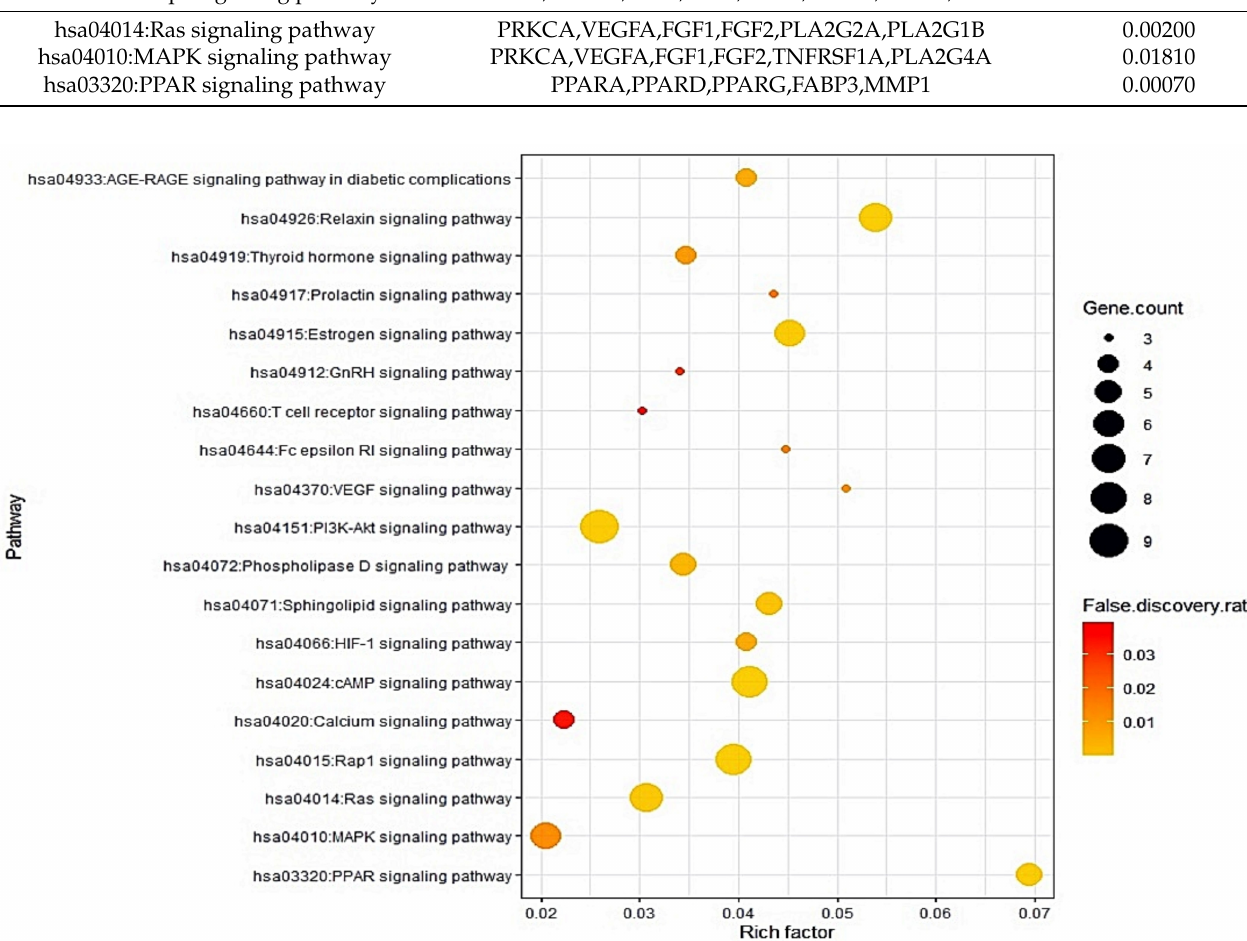
Figure 5. Bubble chart of 19 signaling pathways associated with